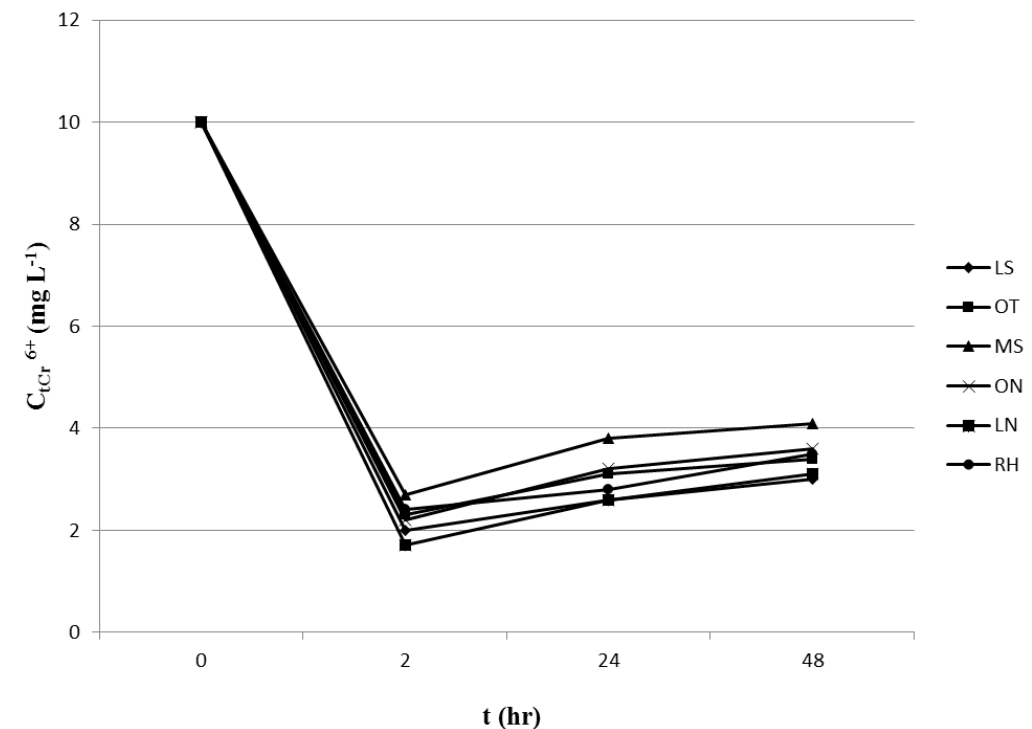
Figure 1. Values of the concentration of Cr VI in solution (C tCr 6+ , mg L -1 ) plotted against time ( t , h) for a C 0Cr6+ of 10 mg L -1